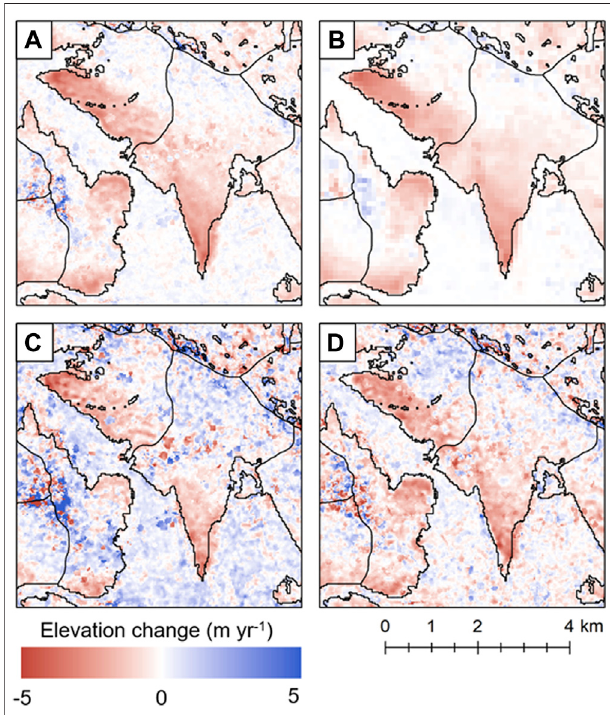
FIGURE 7 | Comparison of datasets over Chumpe Glacier, Cordillera Vilcanota. (A) 2000 to 2020 change in elevation generated by this study, (B) ComparisontoHugonnetetal.(2021)andtheir100 mresolutionproductover the same 20-year time period, (C) 2000 – 2010 change in elevation generated by this study, (D) 2010 – 2020 change in elevation. Black outlines represent the glacier area in 2000 produced by this study.